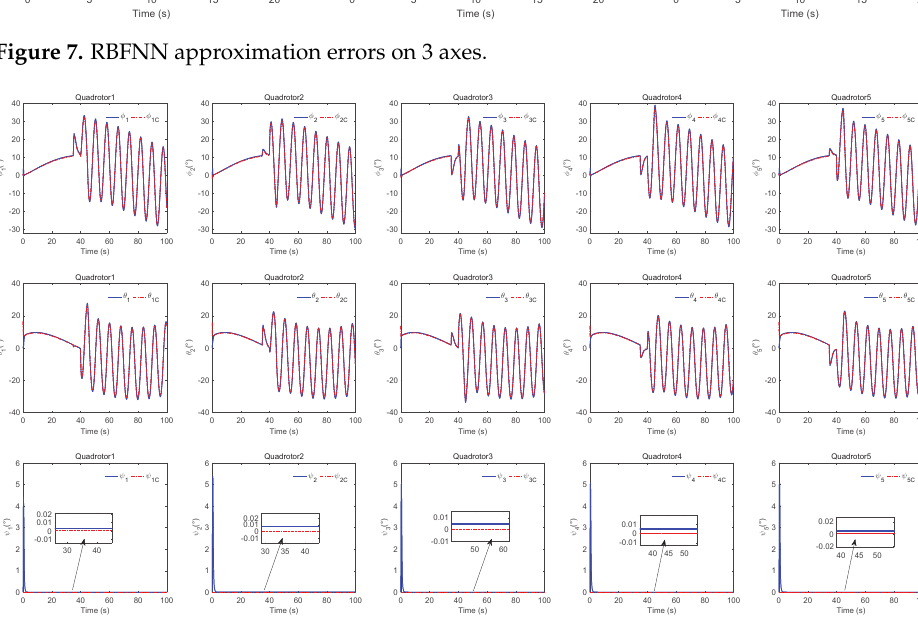
Figure 8. Attitude signals of